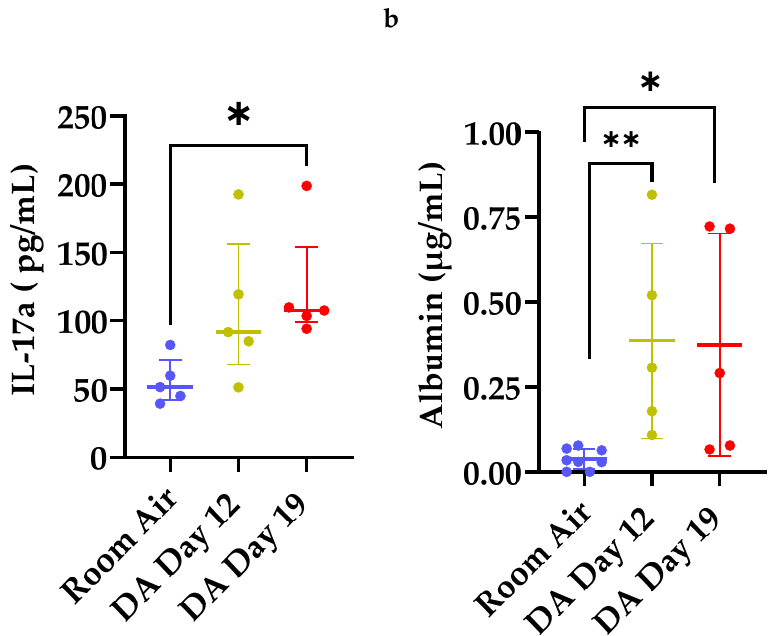
Figure 5. Bronchoalveolar lavage fluid (BALF) expression of ( a ) IL-17a and ( b ) albumin in room air (blue) and DA-exposed rats at Day 12 (yellow) and Day 19 (red). ( a ) BALF IL-17a expression increased significantly in DA D19 rats compared to room air controls (Kruskal–Wallis, * p < 0.05). ( b ) BALF albumin increased significantly in both DA D12 and D19 compared to room air controls (Kruskal-Wallis, ** p < 0.01 and * p < 0.05).